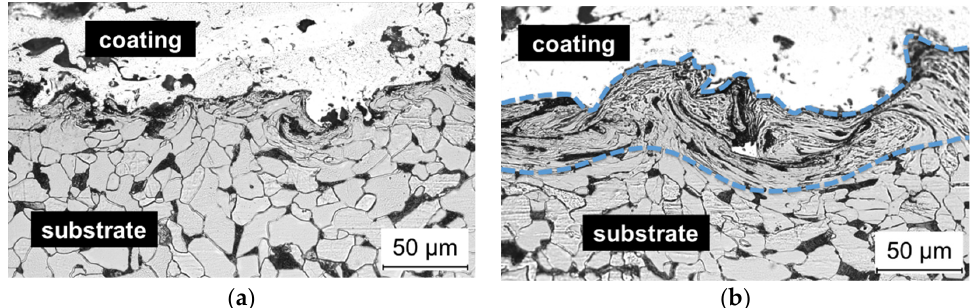
Figure 6. The impact of different surface preparation methods on the base metal microstructure; micro-sections etched with Nital (3%), ( a ) substrate blasted with corundum; ( b ) substrate blasted with steel grit (deformed microstructure bordered by the dashed line).